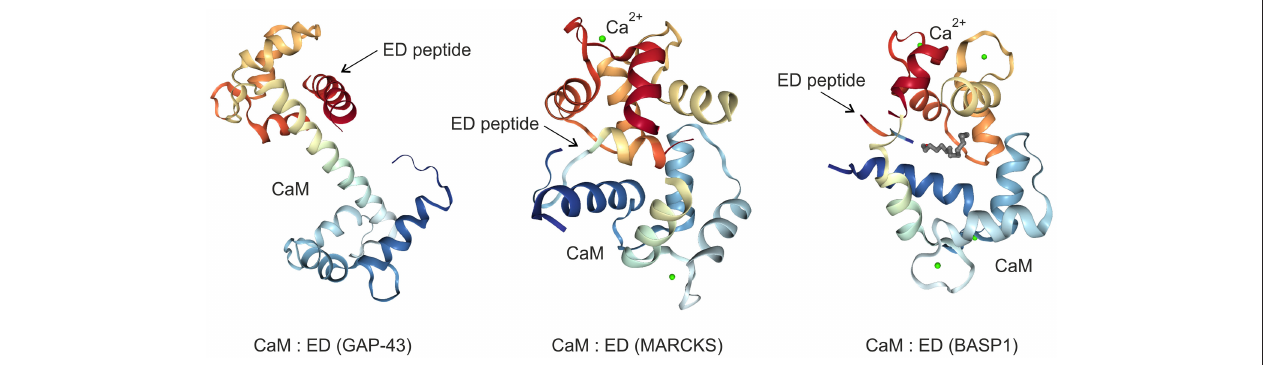
FIGURE 3 | Crystal structures of the GAP43, MARCKS, and BASP1 effector domains (ED) bound to the calmodulin (CaM) protein in the absence (GAP43) or in the presence (MARCKS, BASP1) of calcium ions (Ca 2 + ). The images were created from the protein data bank (PDB) entries 4E53 (27), 1IWQ (44), 1L7Z (6), respectively, and adapted.